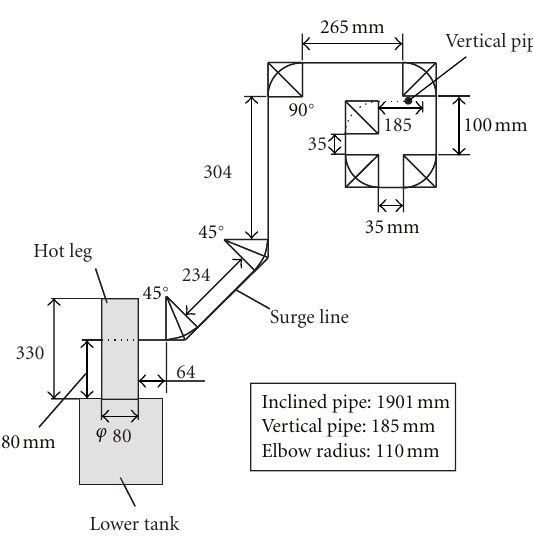
Figure 2: Geometry of surge